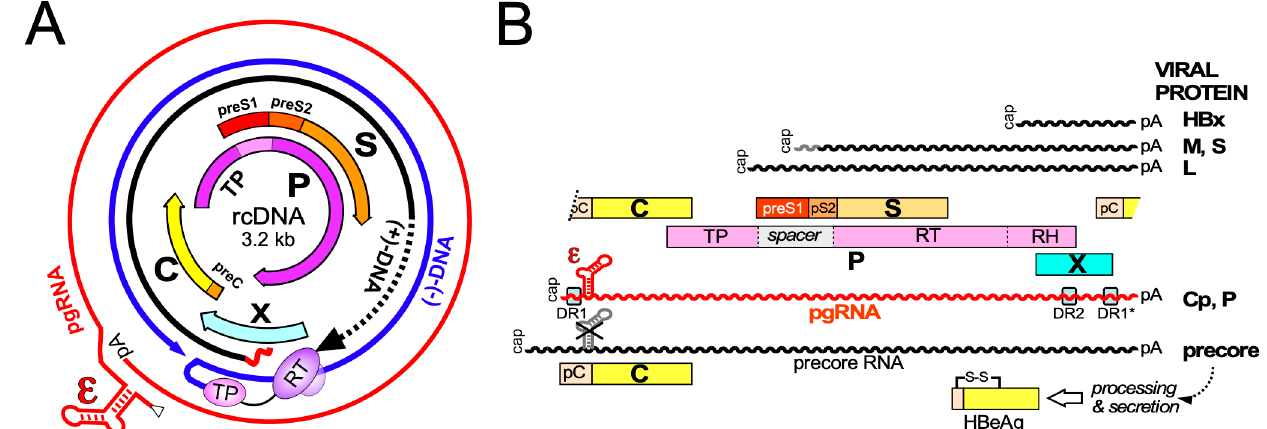
Figure 1. HBV genome organization, transcription, and translation. ( A ) Genome organization. The blue and the black line depict rcDNA with the 5 ′ terminally linked TP domain of P protein on the minus-strand and the RNA primer (red) on the plus-strand; the dashed black line symbolizes the incompletely filled-in 3 ′ end. Colored internal arrows represent the ORFs with their respective preS1, preS2, and preC extensions. The outer red line depicts pgRNA with the 5 ′ proximal ε signal. Note that the actual transcription template is cccDNA, not rcDNA. ( B ) Viral transcripts and protein products. RNAs are shown above (subgenomic) and below (greater-than-genome length) a linear representation of the ORFs as present on the terminally redundant pgRNA; DR1, DR1*, and DR2 are direct repeats involved in rcDNA formation. As is common for eukaryotes, the most cap-proximal ORF on each RNA is translated, for precore protein enabled by the inclusion of the preC start codon in the 5 ′ extension; precore processing at both termini and secretion yield HBeAg (see Section 3.2). Translation of pgRNA yields Cp from the first and P protein from the second ORF; the latter initiation mechanism is still unclear.